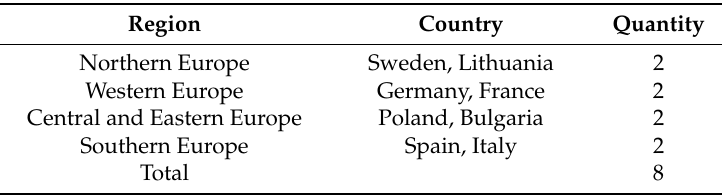
Table 5. Classification of the chosen countries.